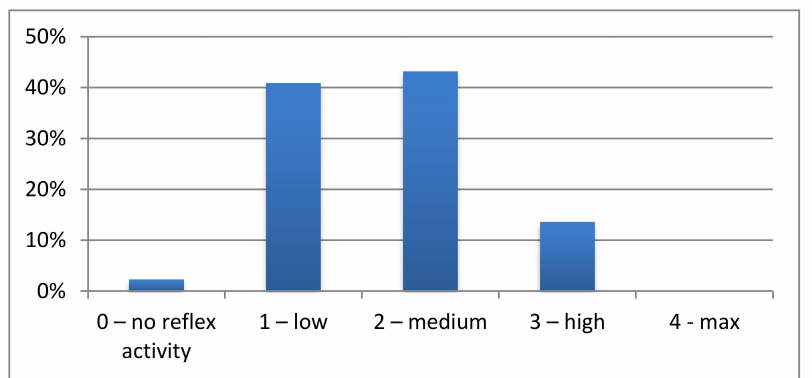
Figure 11. The results of the level of reflex activity.